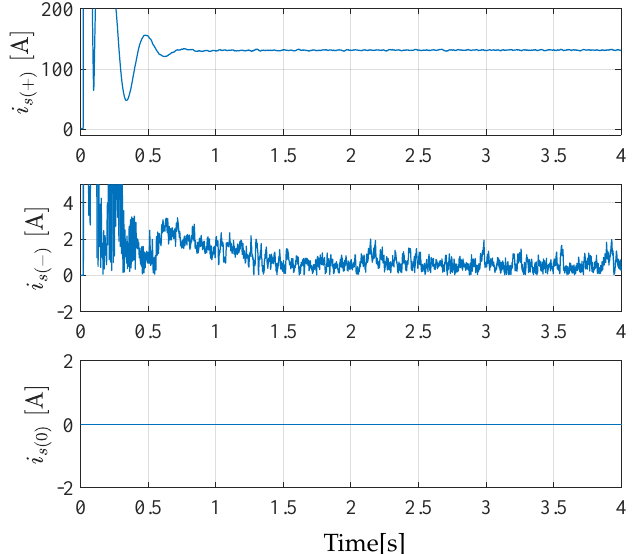
Figure 7. The positive sequence current ( i s (+) ), negative sequence current ( i s ( current ( i s ( 0 ) ) for the currents injected to the